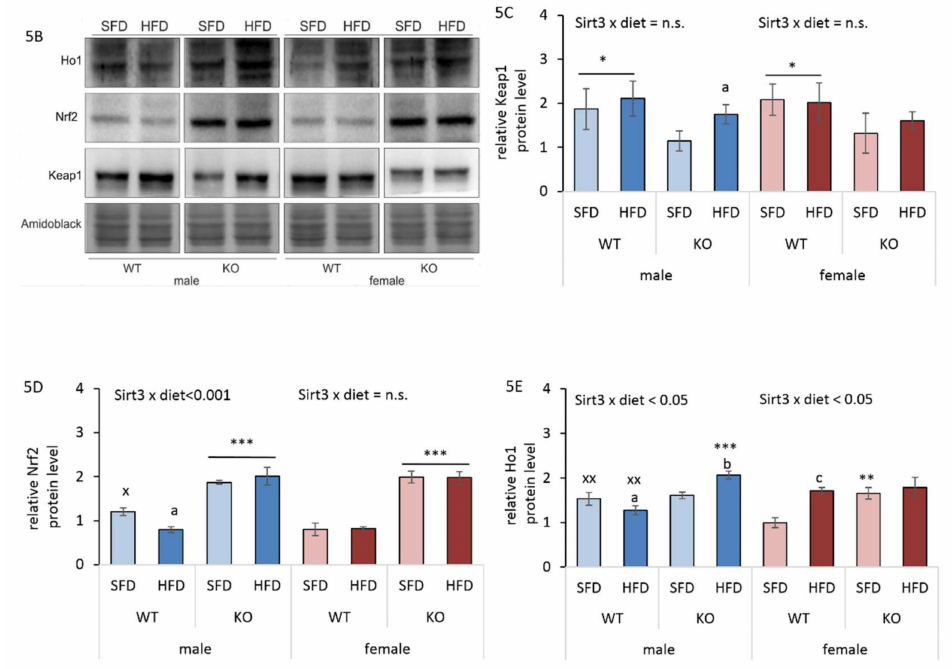
Figure 5. Protein oxidative damage and antioxidant response in the livers of Sirt3 wild-type (WT) and knockout (KO) mice fed with a standard fat diet (SFD) or a high fat diet (HFD) for 10 weeks. ( A ) The total amount of protein carbonyls (PC) measured with an ELISA-based assay at 450 nm. Males: KO vs. WT mice (** p < 0.01). Females: HFD-fed vs. SFD-fed WT mice ( a p < 0.01); SFD-fed KO vs. WT mice (*** p < 0.001). Males vs. females: no changes. The data are shown as mean ± SD. n = 6 per group. ( B ) The representative immunoblots of hepatic Keap1, Nrf2, and Ho1 protein expression. Amidoblack was used as a loading control. ( C ) A graphical display of the averaged densitometry values for Keap-1 protein expression. Males: HFD-fed vs. SFD-fed KO mice ( a p < 0.05); WT vs. KO mice (* p < 0.05). Females: WT vs. KO mice (* p < 0.05). Males vs. females: no changes. ( D ) A graphical display of the averaged densitometry values for Nrf-2 protein expression. Males: HFD-fed vs. SFD-fed WT mice ( a p < 0.001); KO vs. WT mice (*** p < 0.001). Females: KO vs. WT mice (*** p < 0.001). Males vs. females: SFD-fed WT mice ( x p < 0.05). ( E ) A graphical display of averaged densitometry values of Ho-1 protein expression. Males: HFD-fed vs. SFD-fed WT mice ( a p < 0.05); HFD-fed vs. SFD-fed KO mice ( b p < 0.01); HFD-fed KO vs. WT mice (*** p < 0.001). Females: HFD-fed vs. SFD-fed WT mice ( c p = 0.002); SFD-fed KO vs. WT mice (** p < 0.01). Males vs. females: WT mice ( xx p < 0.05). The data are shown as mean ± SD. n =